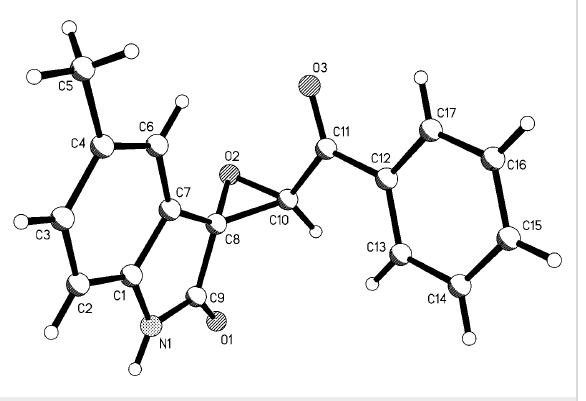
Figure 1: Molecular structure of spiro compound 3c .